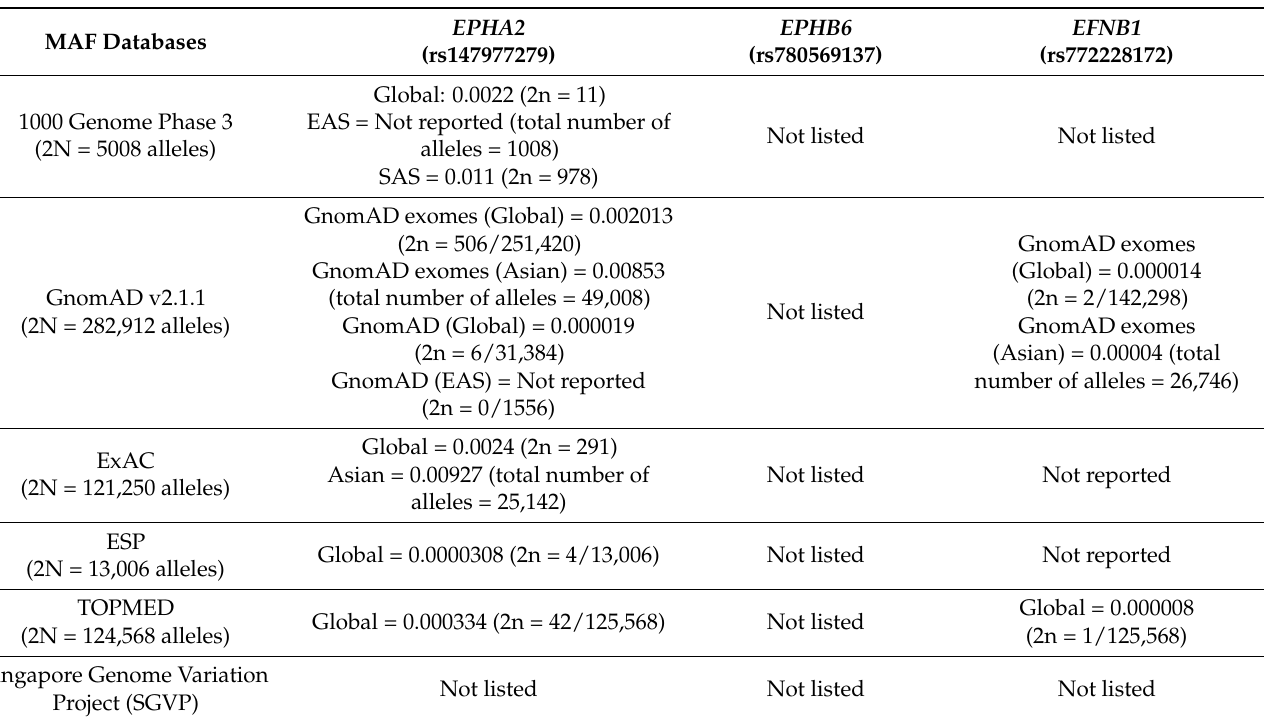
Table 3. Minor Allele Frequency (MAF) databases information specific for EPHA2